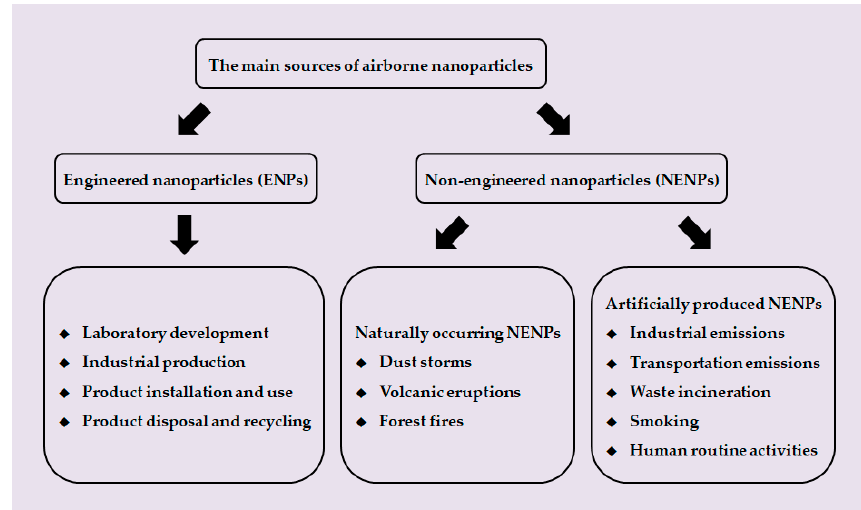
Figure 4. A summary of the main sources of airborne NPs. The sources of airborne NPs can be broadly divided into two categories: ENPs and NENPs. ENPs are made by artificially controlled engineering processes (i.e., laboratory development, industrial production, product installation and use, product disposal, and recycling). NENPs are the by-products of some natural activities (i.e., dust storms, volcanic eruptions, and forest fires) or human activities (i.e., industrial emissions, transportation emissions, waste incineration, smoking, and human routine activities).